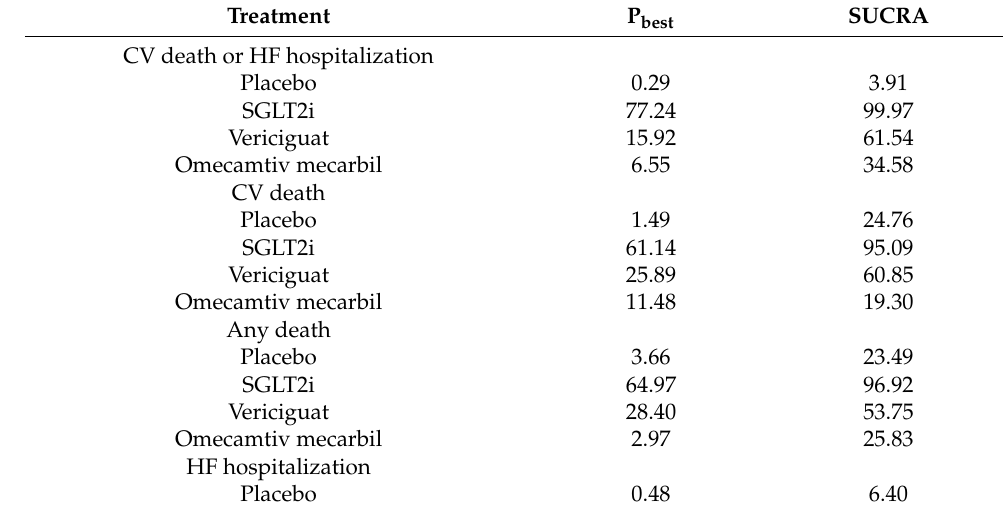
Table 3. Probability ranks for primary and secondary